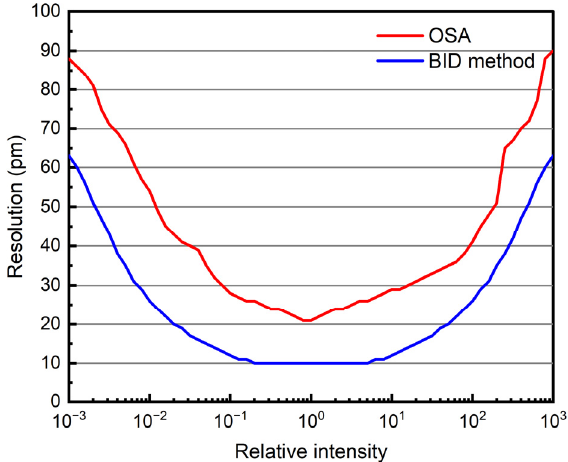
Figure 1. Resolution of OSA versus boosted iterative deconvolution (BID) method as a function of relative intensity.